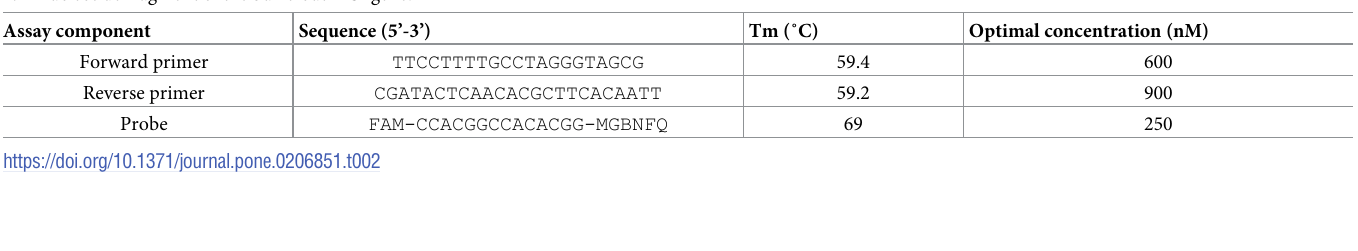
Table 2. Primers and probe sequences, estimated annealing temperatures (Tm), and optimal primer concentrations of the eDNA assay for bull trout ITSI. Optimal primer concentrations refer to the lowest concentration of primers resulting in the earliest Ct while maintaining a high end-point fluorescence. The assay amplifies a 172-nucleotide fragment of the bull trout ITSI